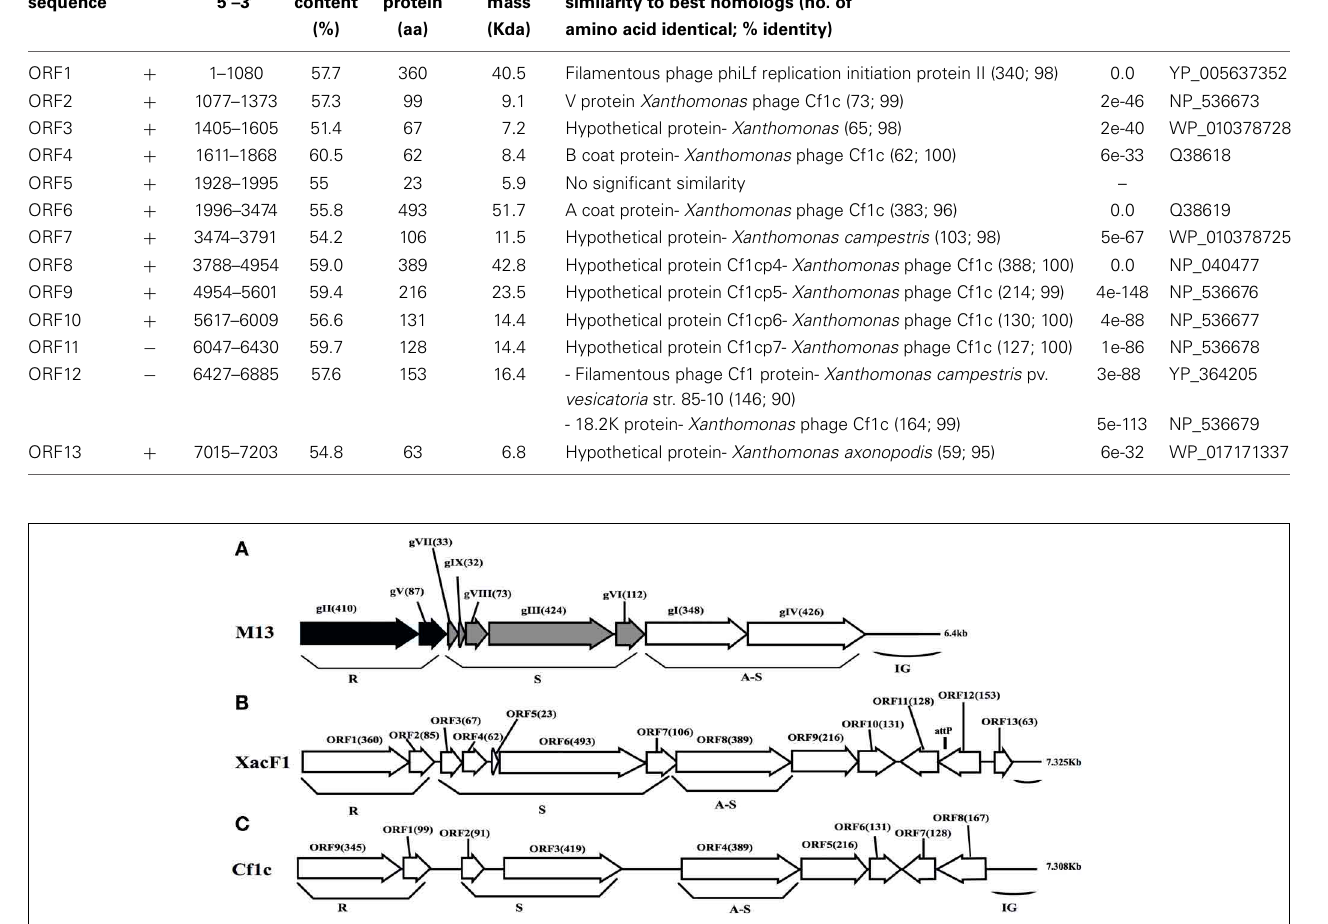
assembly-secretion (A-S) are indicated according to the M13 model (Marvin, 1998). Map for Cf1c was drawn according to the genomic sequence (accession no. NC_001396, Kuo et al., 1991). ORF sizes (in amino acids) are in parentheses. IG (intergenic region), and att P are also